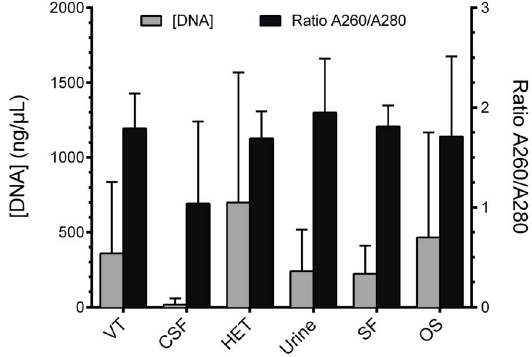
Figure 2. DNA concentrations and purity from the different clinical samples studied. Sample type: VT, vertebral or paravertebral tissue; CSF, cerebrospinal fluid; HET, hepatic or splenic tissue; SF, synovial fluid; OS, other samples.